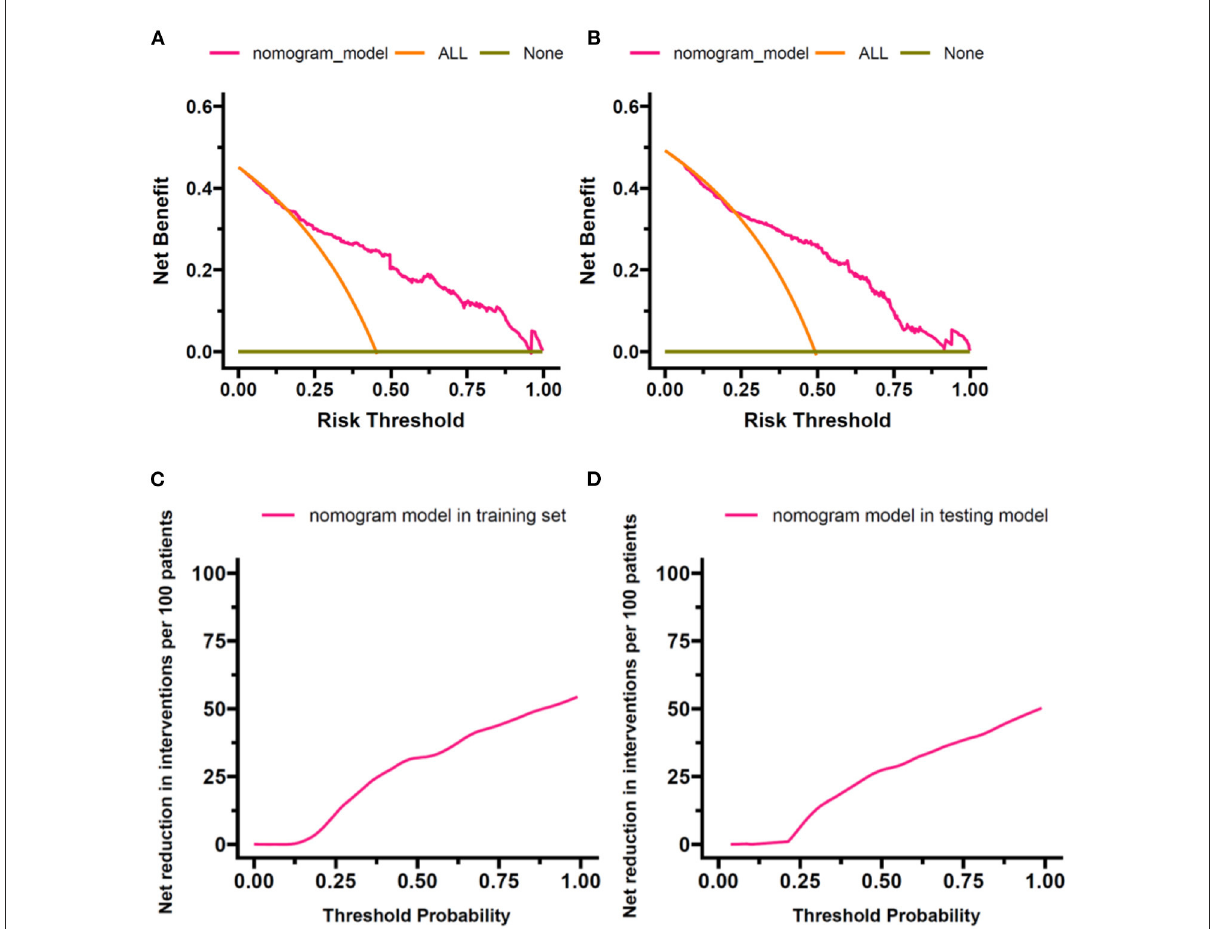
FIGURE5 Results of DCA. DCA was performed to compare the nomogram-based decision with default strategies, which assume that all or no observations received interventions. (A) Net benefit against threshold probability in the training set. (B) Net benefit against threshold probability in the testing set. (C) Net reduction in interventions per 100 patients against threshold probability in the training set. (D) Net reduction in interventions per 100 patients against threshold probability in the testing set. DCA, decision curve